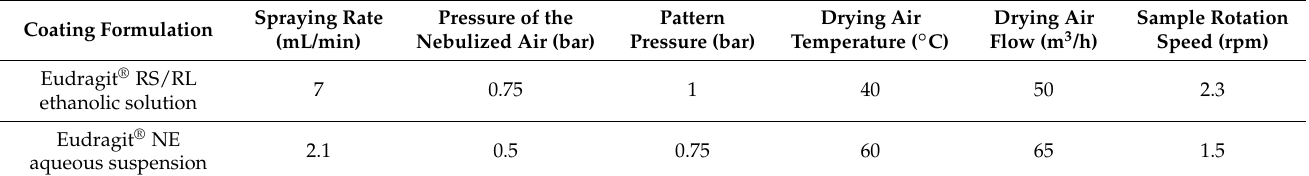
Table 2. Coating process conditions.